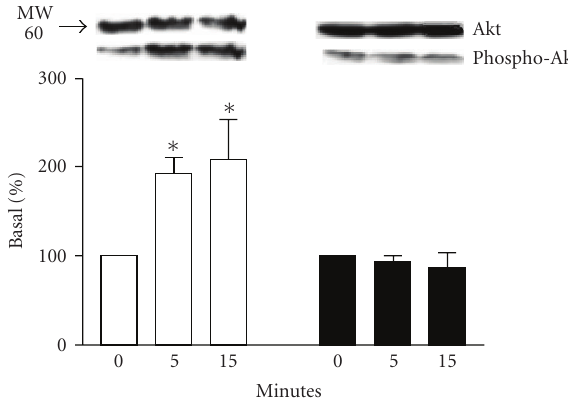
Figure 6: Akt activity with chimeric β -AR stimulation . HEK 293 cells were transfected with β 1 × β 2 -AR or β 2 × β 1 -AR. Forty-eight hours after the transfection, cells were stimulated with 1 μ M isoproterenol for the indicated times. Akt activity was determined by measuring levels of phosphorylated Akt compared with total Akt produced by the stimulation of β 1 × β 2 -AR ( (cid:2) ) or β 2 × β 1 -AR ( (cid:3) ) expressing cells. Upper panel is a representative immunoblot of the experiments ( n = 6-7). Data from these experiments is quantitated in the bottom panel as described in Section 2. ∗ P < . 05 versus 0